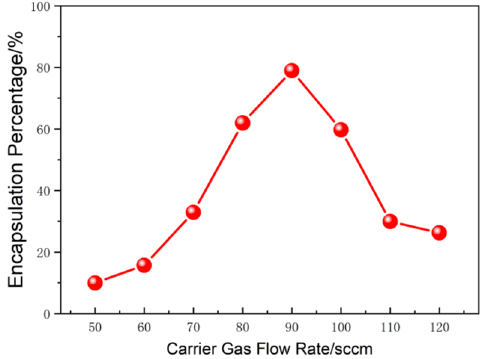
Figure 4. Encapsulation rate variation with the carrier gas flow rate.